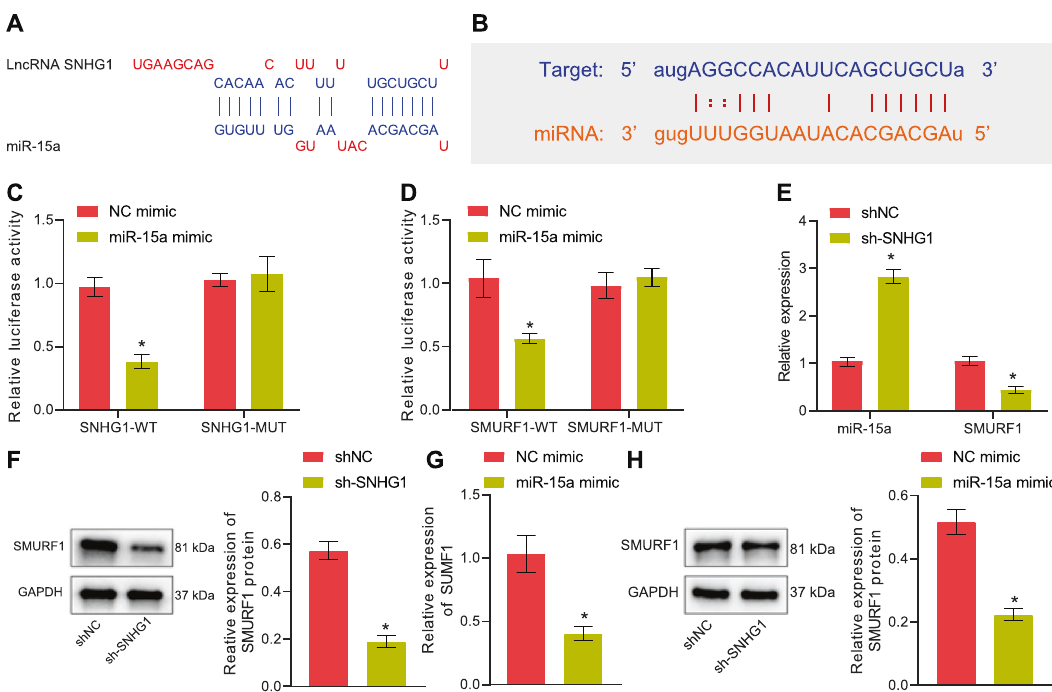
Fig. 5 LncRNA SNHG1 binds to miR-15a to upregulate SMURF1. A Prediction of lncRNA SNHG1 binding sites with miR-15a and wild-type/ mutant plasmid sequences. B Prediction of miR-15a binding sites in SMURF1 3'UTR and wild-type/mutant plasmid sequences. C Dual- luciferase assay to measure the binding of lncRNA SNHG1 to miR-15a. D Dual-luciferase assay to detect the binding of SMURF1 3'UTR to miR- 15a. E The regulatory effect of lncRNA SNHG1 on SMURF1 and miR-15a determined by RT-qPCR. F The regulatory effect of lncRNA SNHG1 on SMURF1 and miR-15a detected by Western blot analysis. G RT-qPCR to assess the regulation of SMURF1 by miR-15a. H The regulation of SMURF1 by miR-15a detected by Western blot analysis. * p < 0.05 vs . BMSCs transfected with sh-NC or NC mimic. The cell experiments were repeated three